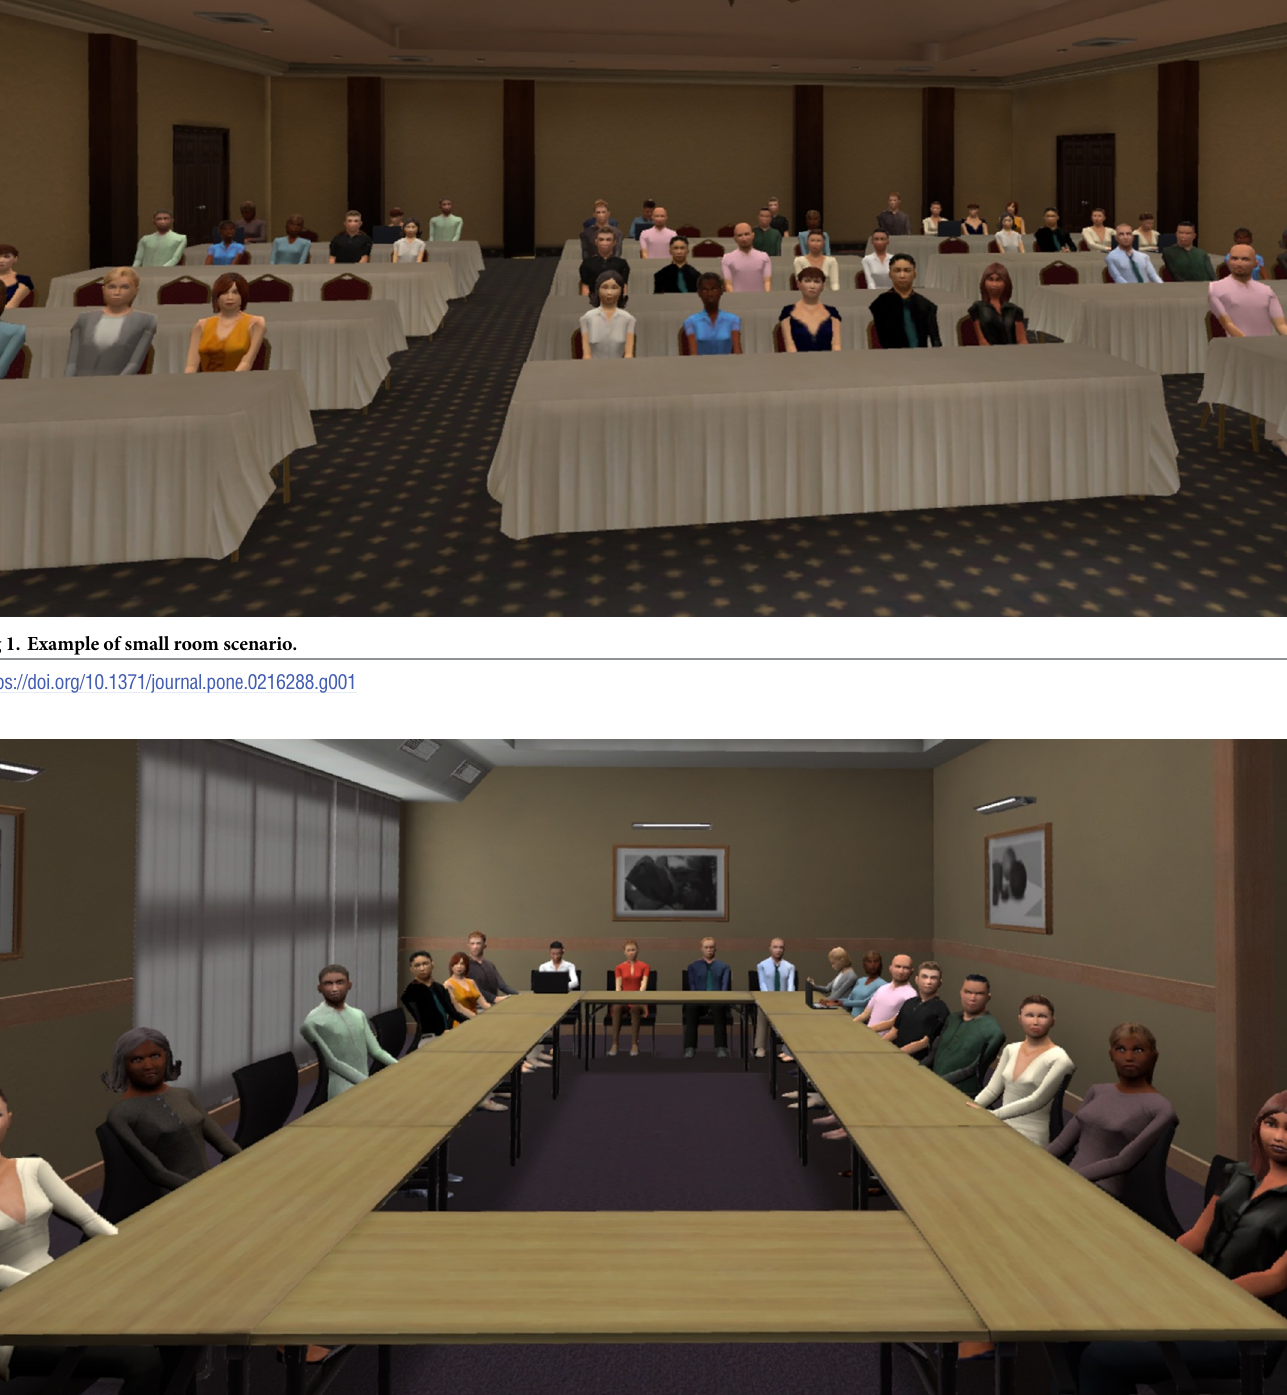
PLOS ONE | https://doi.org/10.1371/journal.pone.0216288 May 31,